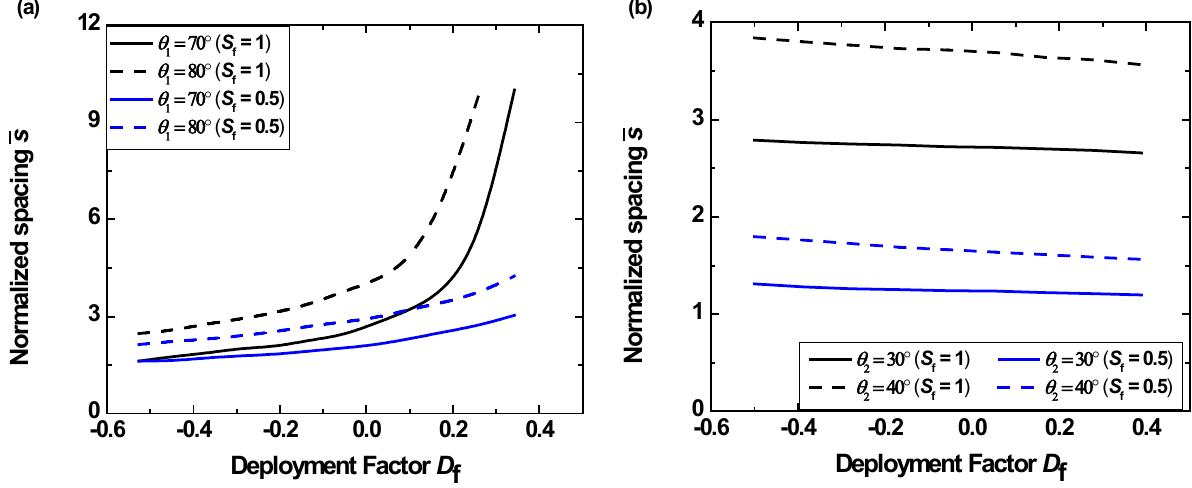
Figure 11. The predicted contours of the bending angles as a function of the normalized spacing and the deployment factor for different normalized sulcus